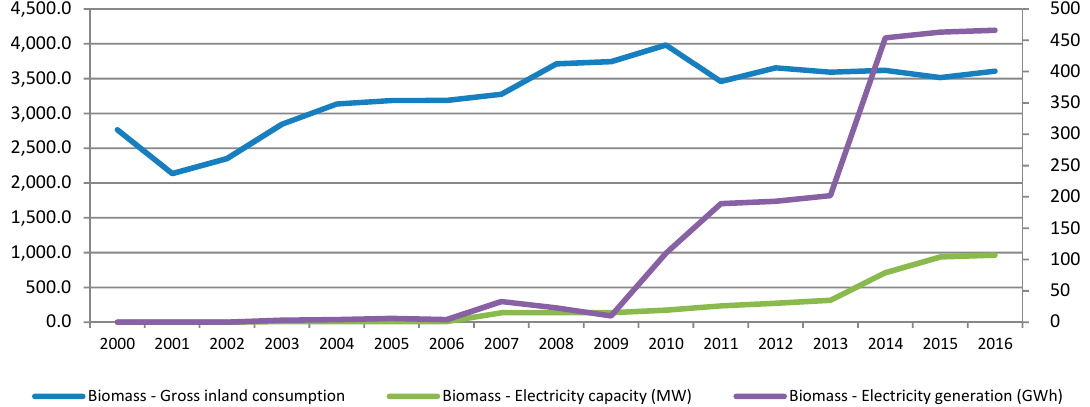
Figure 17. Main indicators evolution for biomass, 2000–2016, Source: Own research based on Eurostat data [12].